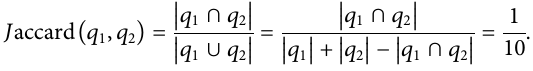
Frontiers in Bioengineering and Biotechnology |